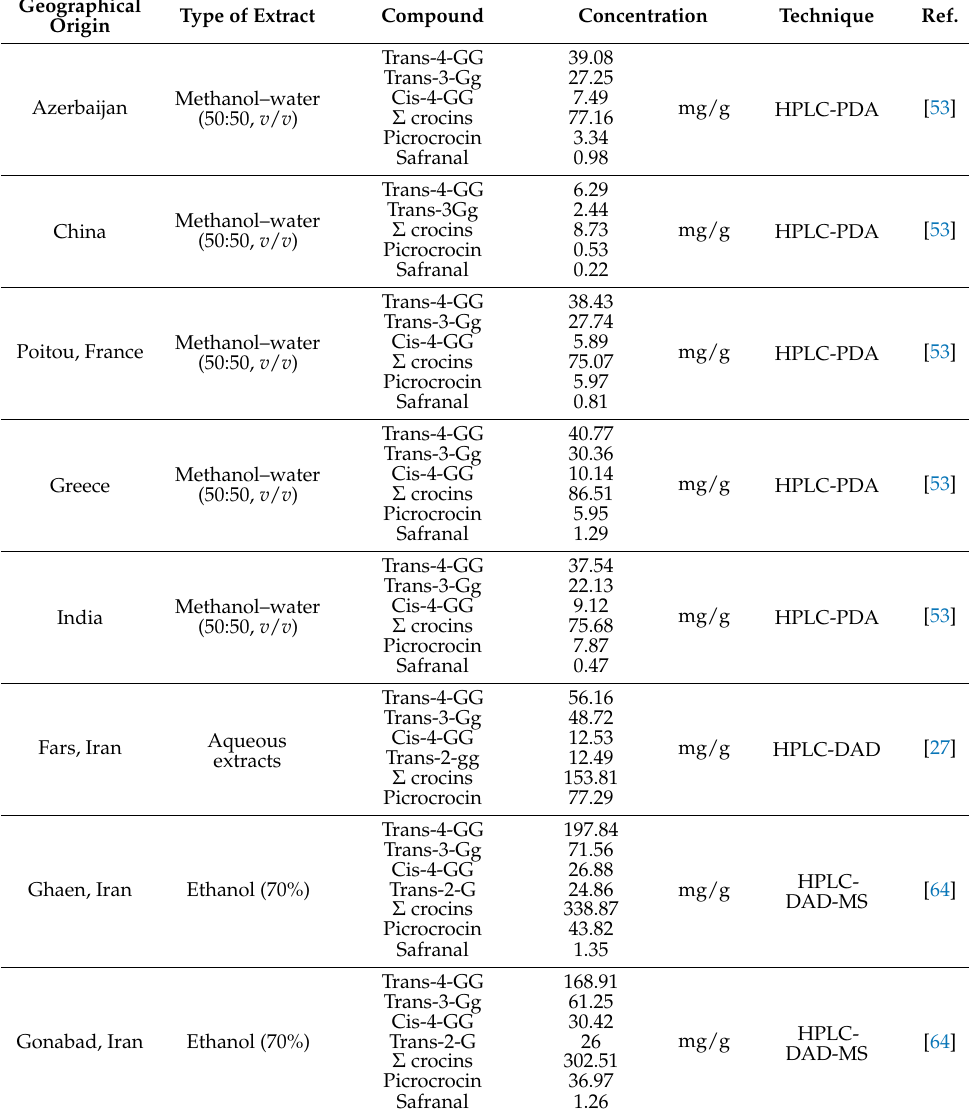
Table 1. Principal quality chemical components of saffrons obtained from different geographical origins and their